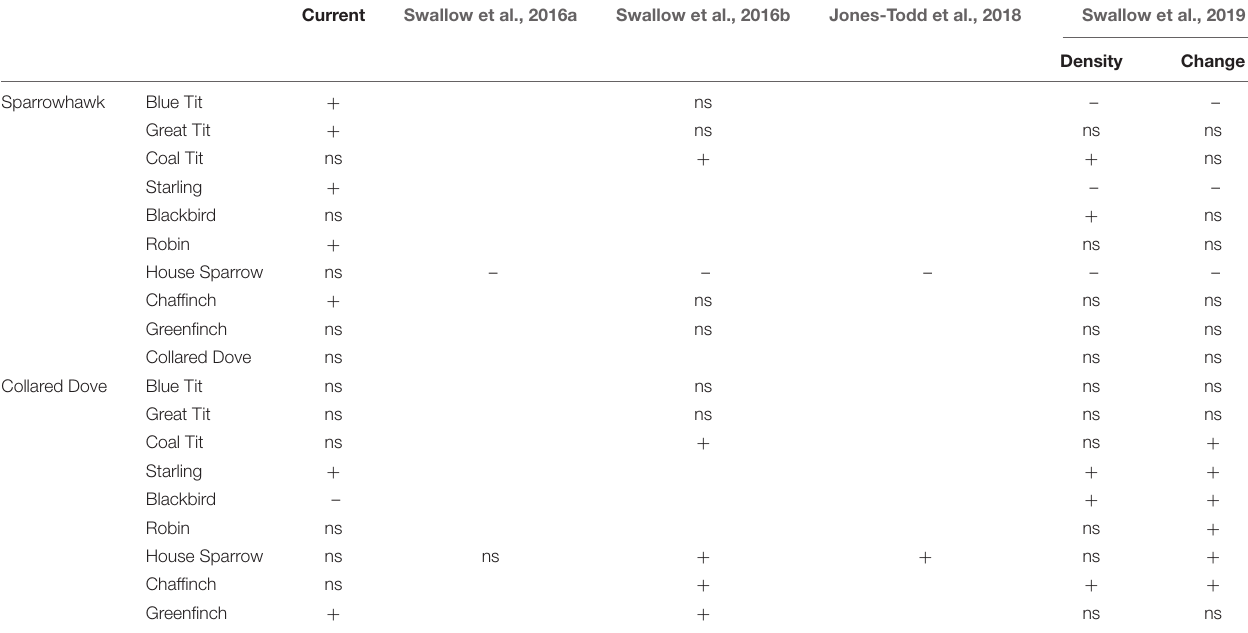
TABLE 7 | Comparison of current results with those of recent analyses using GBFS